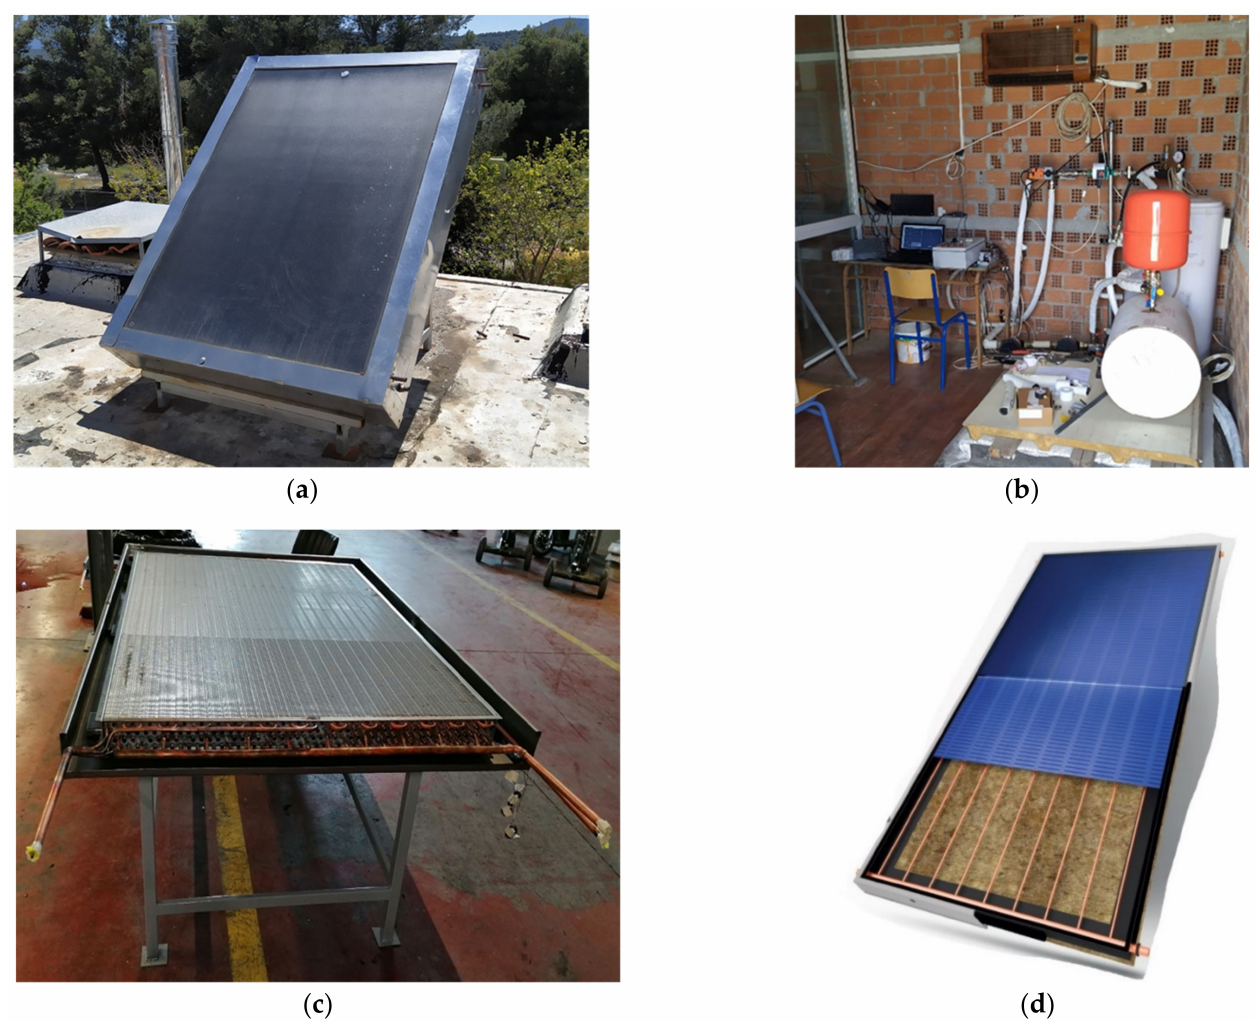
Figure 2. Pictures of the experimental rig of the Solar Kit apparatus: ( a ) the Solar Kit unit; ( b ) data acquisition and control; ( c ) heat exchanger; and ( d ) solar